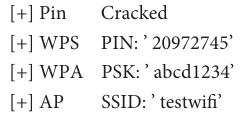
Figure 9: Reaver crack results